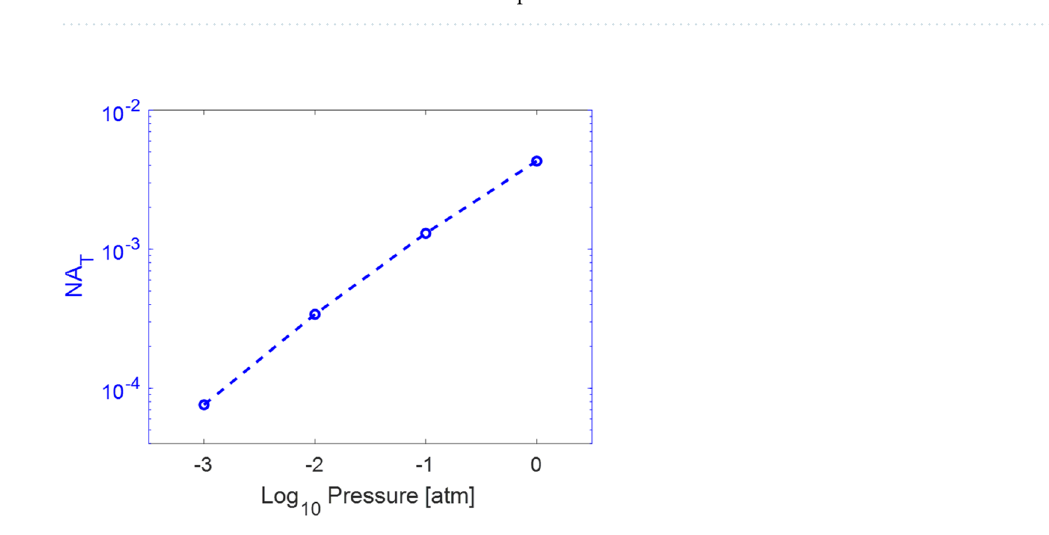
Table 1. Initial conditions for simulations at each pressure modeled from 1 to 0.0035 atm.